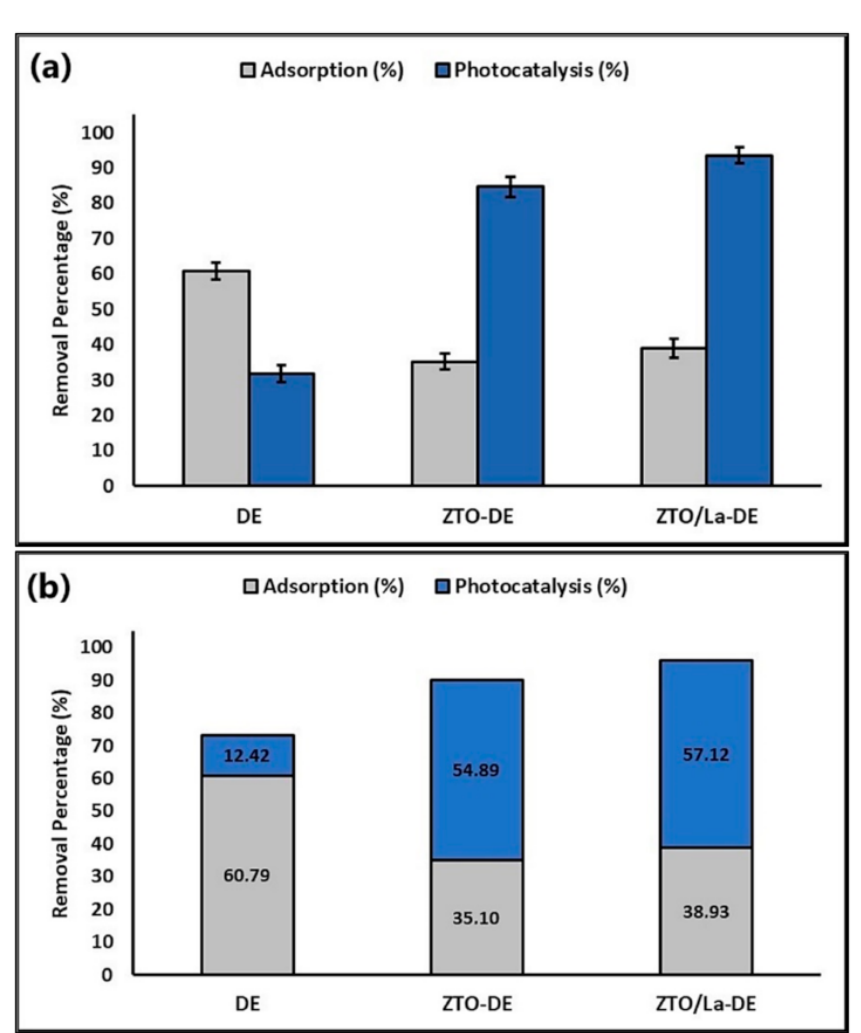
Figure 11. Percentage of ( a ) individual and ( b ) accumulated MB adsorbed and photodegraded by the composites.